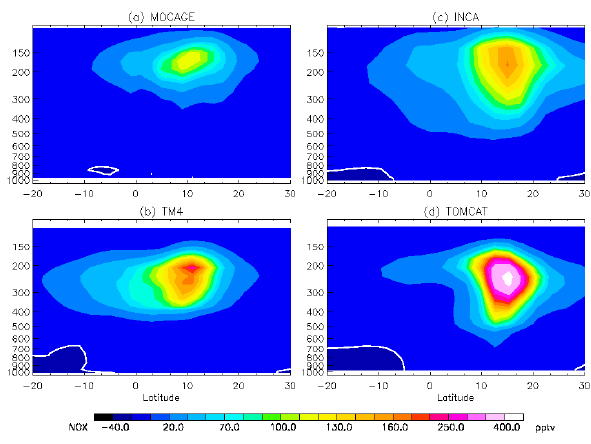
Fig. 12. August 2006 LiNO x latitude-pressure cross-sections aver- aged over 30 ◦ W–30 ◦ E computed as the difference between Base- line and LiNO x -off simulations by (a) MOCAGE (b) TM4 (c) INCA and (d) p-TOMCAT.